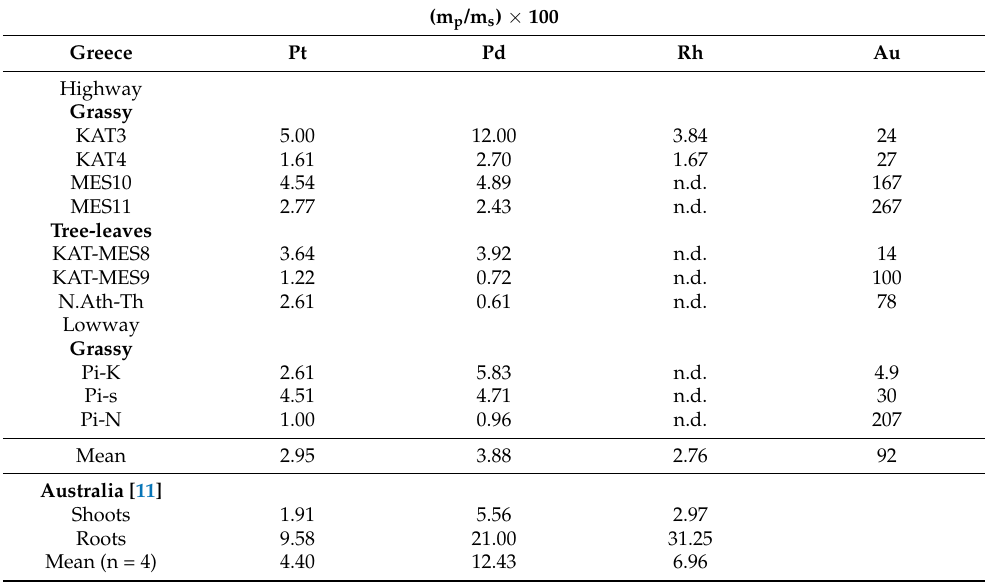
Table 3. Percentage of soil Pt, Pd, Rh, and Au in plants from the Athens Basin, Greece. Data from Tables 1 and